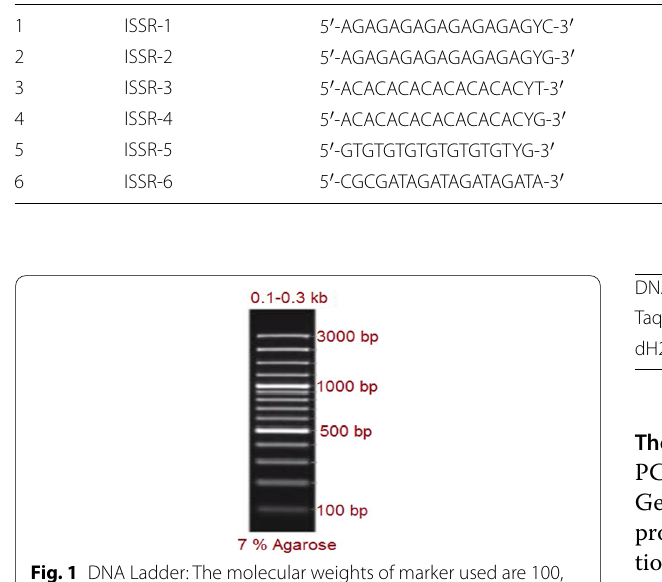
Table 2 Name and sequences of the selected ISSR primers used in ISSR analysis profile No